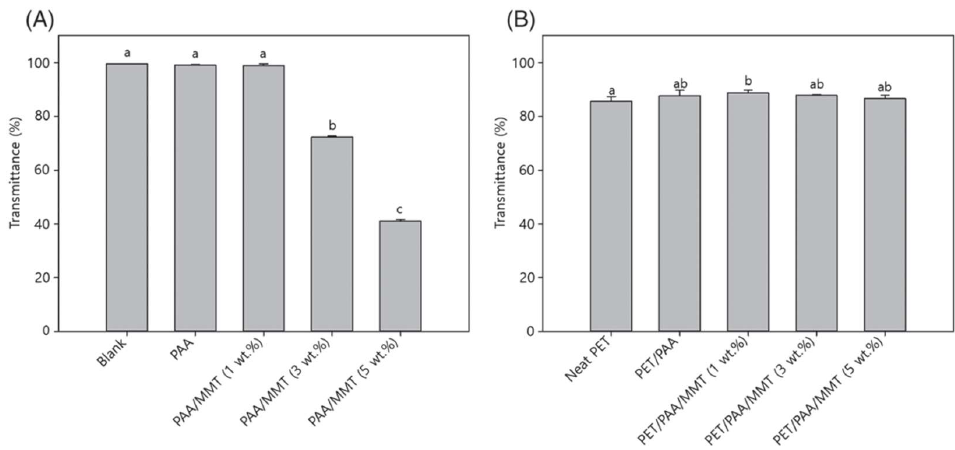
Figure 4. Barrier properties of water vapor (a) and oxygen permeability of polymer nanocomposite. (a) the polyacrylic acid (PAA)/montmorillonite (MMT) and (b) the polyethylene terephthalate (PET) films coated with PAA/MMT nanocomposites (reproduced with permission from [41] copyright 2021, Wiley).